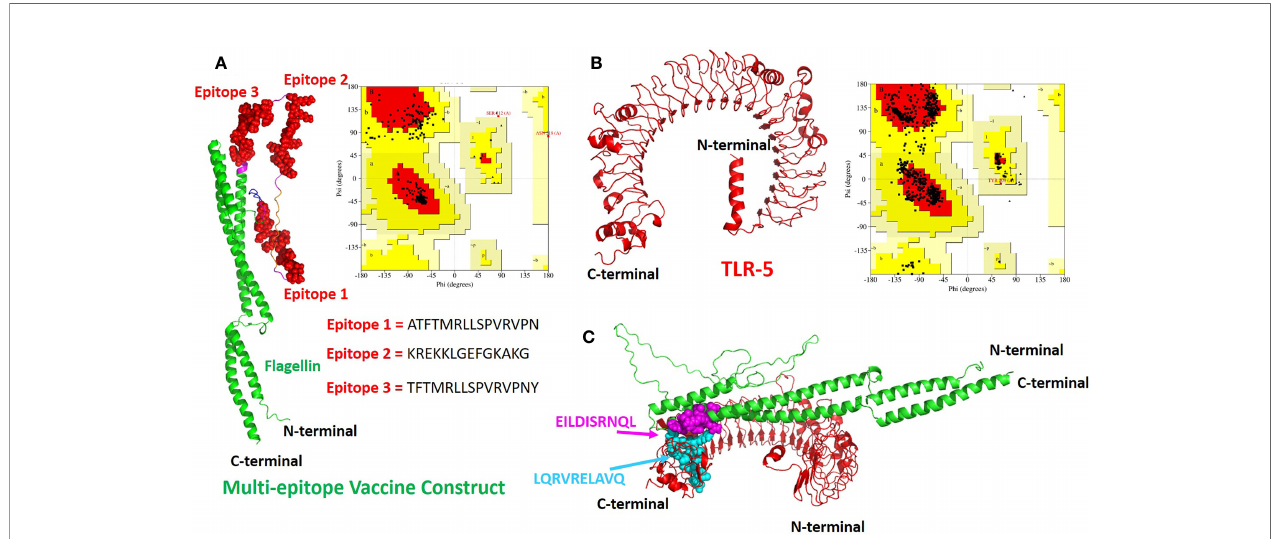
FIGURE 2 | The modeled 3D structures of the (A) multi-epitope vaccine construct. The three epitopes inserted are shown in red spheres and the bacterial fl agellin sequence is present at the N- and C-terminal of the vaccine construct and is colored in green cartoons.; (B) Toll like Receptor 5(TLR-5) immunological receptors used in this study. Respective Ramachandran plots also also shown with predicted structures (C) The docked complex of multi-epitope vaccine and TLR-5 is shown where the hotspot residues used (see Methods section for details) for data driven docking have been shown in spheres and colored in magenta and cyan for multi- epitope vaccine construct and TLR-5 receptor